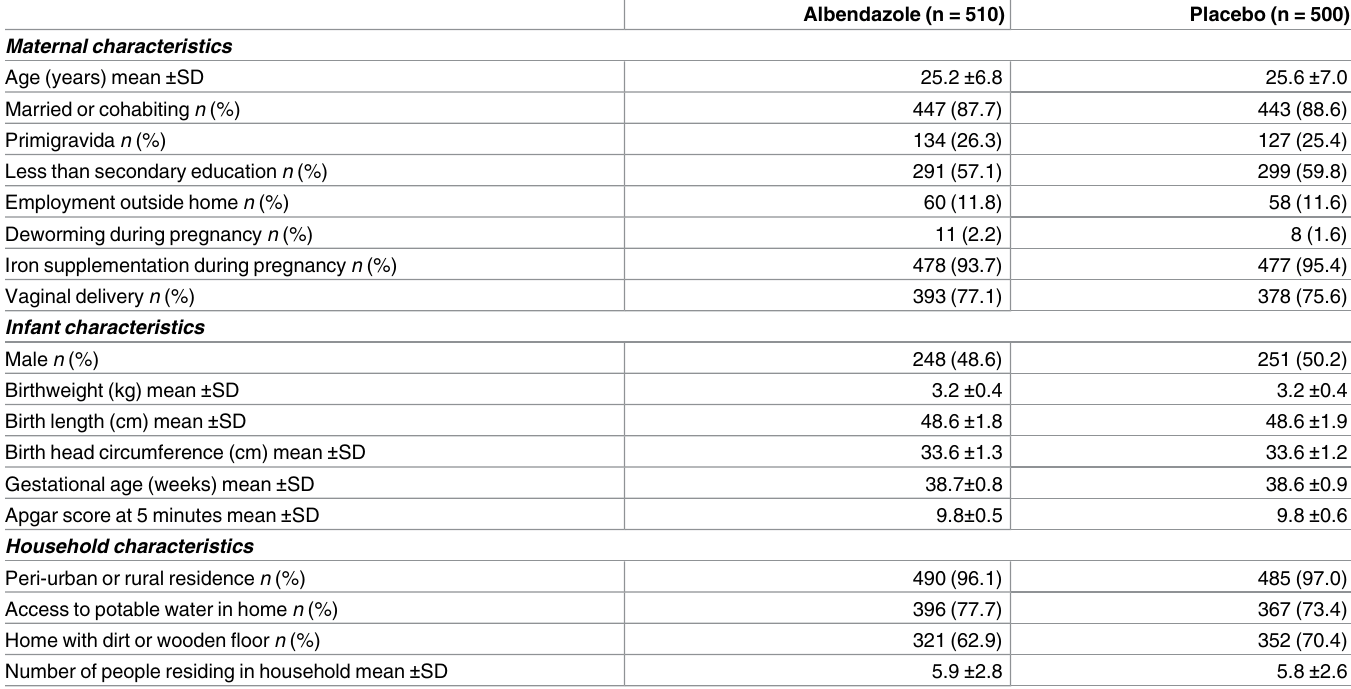
Table 1. Baseline characteristics of mothers and infants (N = 1010) by intervention group, Iquitos, Peru (February–August